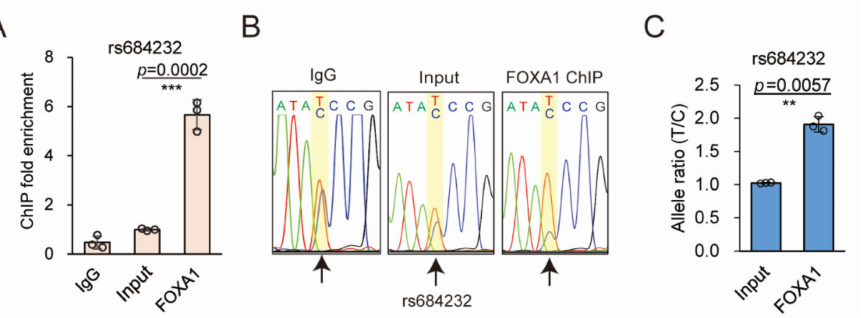
Figure 4. SNP rs684232 alters FOXA1 binding. ( A ) Enrichment of rs684232 region in the FOXA1 ChIP DNA in 22Rv1 cells. IgG and Input as the negative control. Mean ± SD of three technical replicates. *** p < 0.001, two − tailed Student’s t -test. ( B ) Sanger sequencing chromatography of FOXA1 ChIP DNA for the rs684232 site in 22Rv1 cells. IgG and Input as the negative control. The position of rs684232 is highlighted with a yellow square and arrow. ( C ) Allele − specific enrichment of rs684232 site in the FOXA1 ChIP DNA determined by AS − qPCR in 22Rv1 cells. Mean ± SD of three technical replicates. ** p < 0.01, two − tailed Student’s t